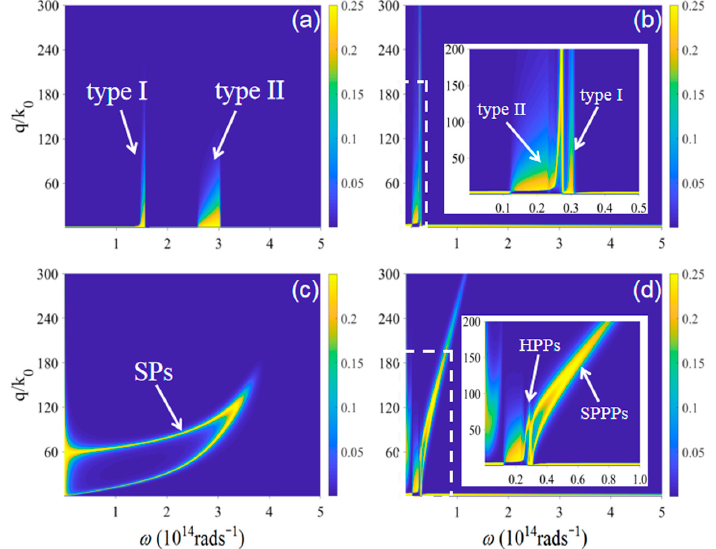
Figure 5. The photon exchange functions in different configurations. ( a ): hBN; ( b ): Bi 2 Se 3 ; ( c ): graphene; ( d ): graphene-covered Bi 2 Se 3 . The chemical potential of graphene is µ = 0.2 eV and the separation distance is d = 20 nm. The insets in ( b , d ) are the enlarged areas denoted by white dashed